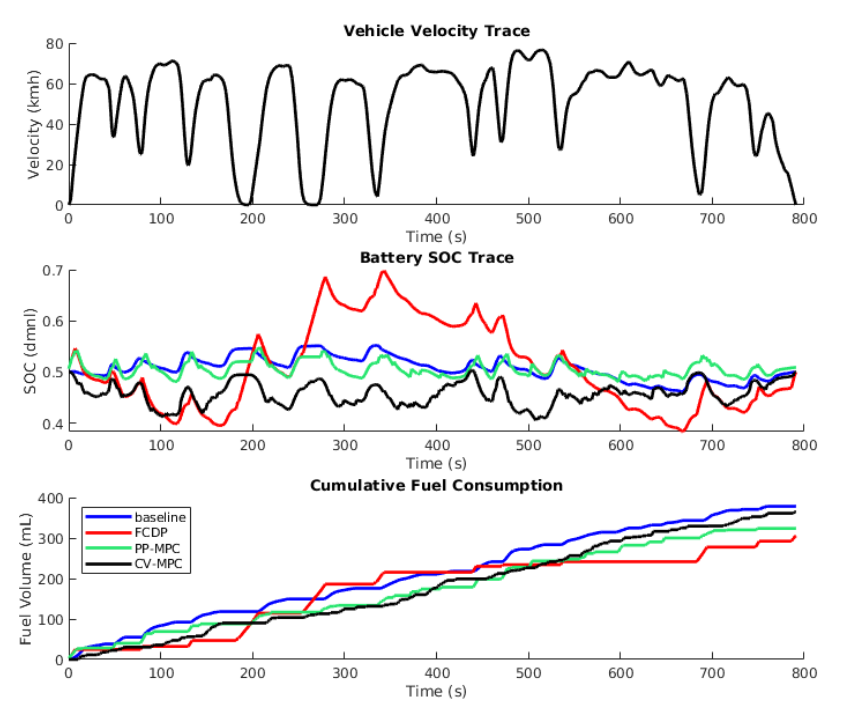
Figure 6. Comparison of DP-derived methods and Autonomie baseline control on sample drive cycle.